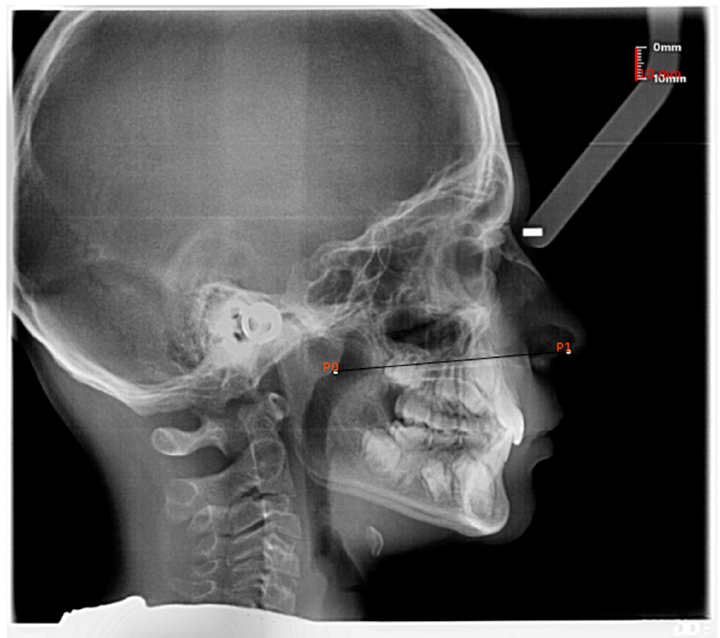
Figure 2. Measurement of the nostril to nasopharynx distance in a subject with adenoid hypertrophy. In the presence of adenoid hypertrophy, the posterior landmark was taken on the outline of the adenoid tissue.